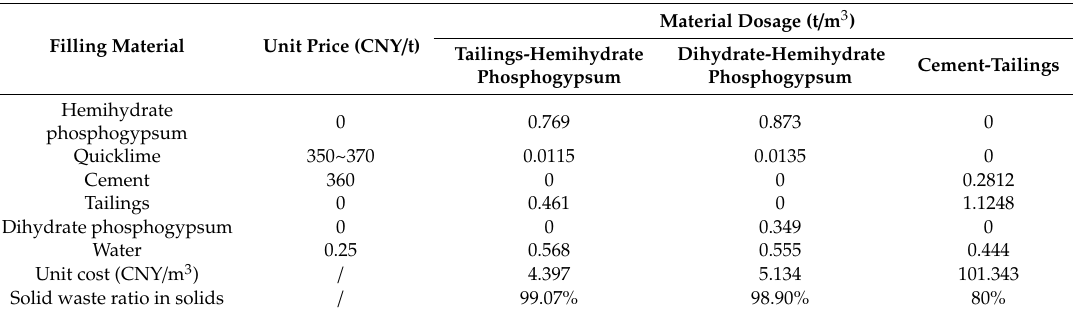
Table 7. Filling cost